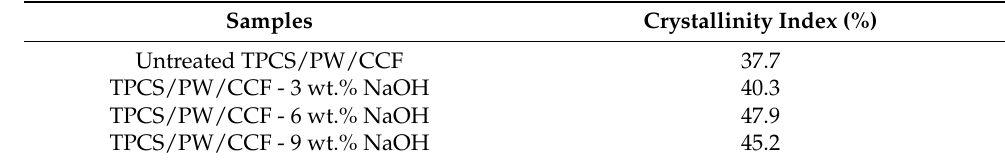
Figure 7. X-ray diffraction spectra of the untreated and treated TPCS/PW/CCF composites. Table 3. Crystallinity index of untreated and treated TPCS/PW/CCF composites.